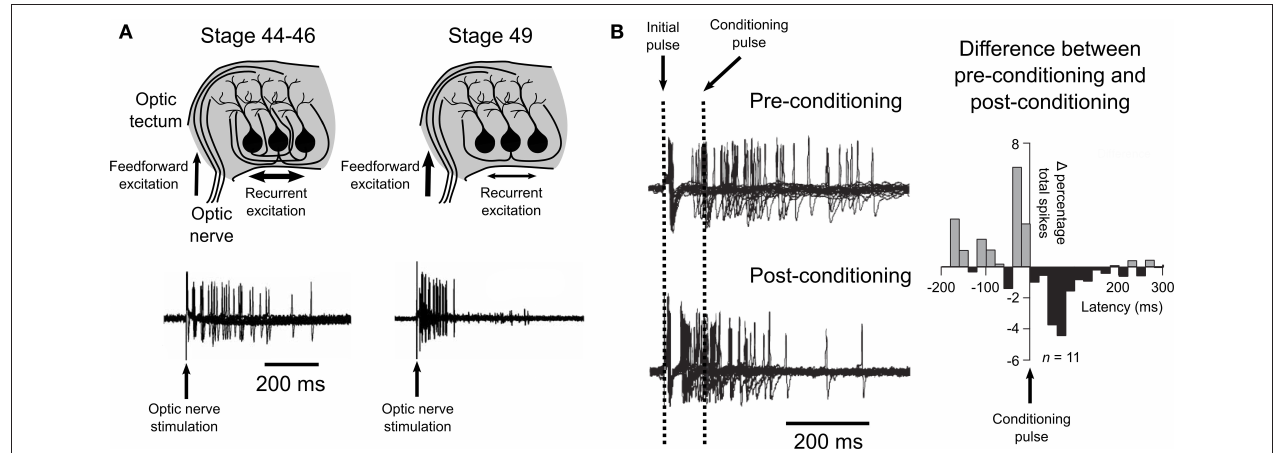
Figure 4 | Spike-timing-dependent plasticity and recurrent excitatory circuits in the optic tectum. (A) Pratt et al. (2008) observed evidence for a developmental refinement of the recurrent excitatory circuitry of the tectum between stages 44 and 49. Stimulation of the optic nerve at early stages (44–46) produced prolonged spiking activity, while stimulation at a later stage (49) produced an initial strong response that did not show prolonged activity, as